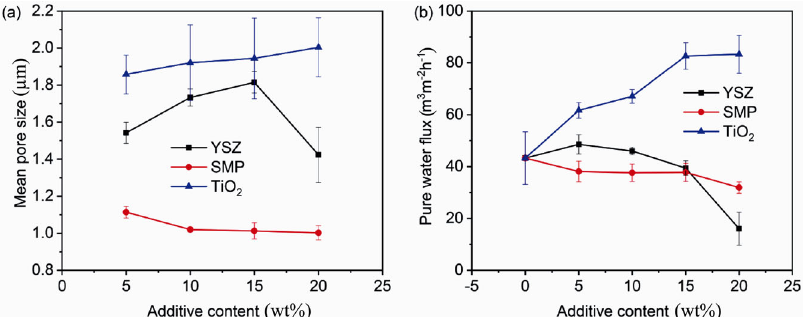
Fig. 5 Effects of additive contents on (a) mean pore size, and (b) pure water flux of mullite hollow fiber membranes sintered at 1570 ℃ .